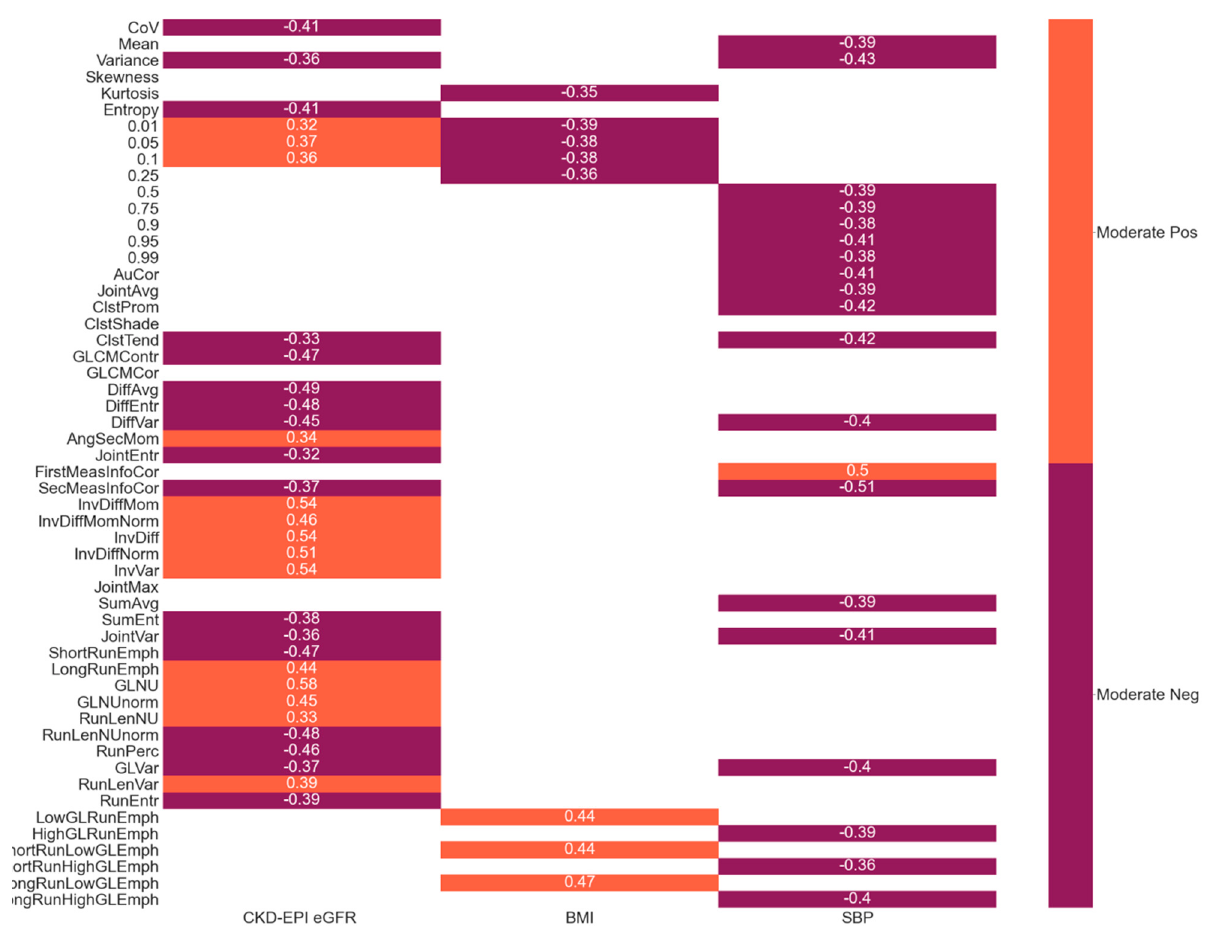
Figure 4. Correlation map of radiomic and clinical features. Shown is a color-coded correlation map between radiomic and clinical features. Only statistically significant ( p < 0.05) correlations are displayed. There were no significant correlations in the categories of age, sex, diastolic blood pressure, eGFR slope, 24 h urine protein, or blood glucose. Spearman ρ value of correlations is displayed. The color coding was based on the Spearman ± ρ values; however, all correlations were moderate (0.3 to 0.7) and indicated as positive (pos) or negative (neg). Abbreviations: CKD: chronic kidney disease; CKD-EPI: CKD Epidemiology Collaboration; eGFR: estimated glomerular filtration rate; SBP: systolic blood pressure; BMI: body mass index.